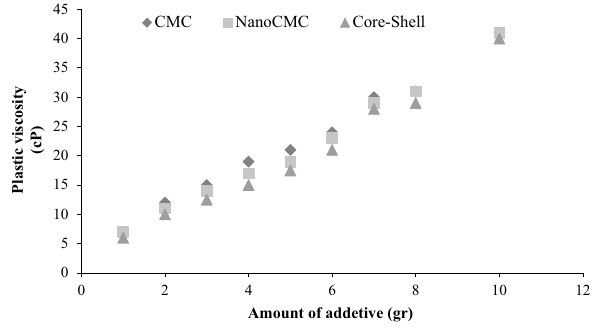
Fig. 12 Comparison of plastic viscosity of drilling fluid with bulk CMC, nanoCMC and core–shell nanocomposite